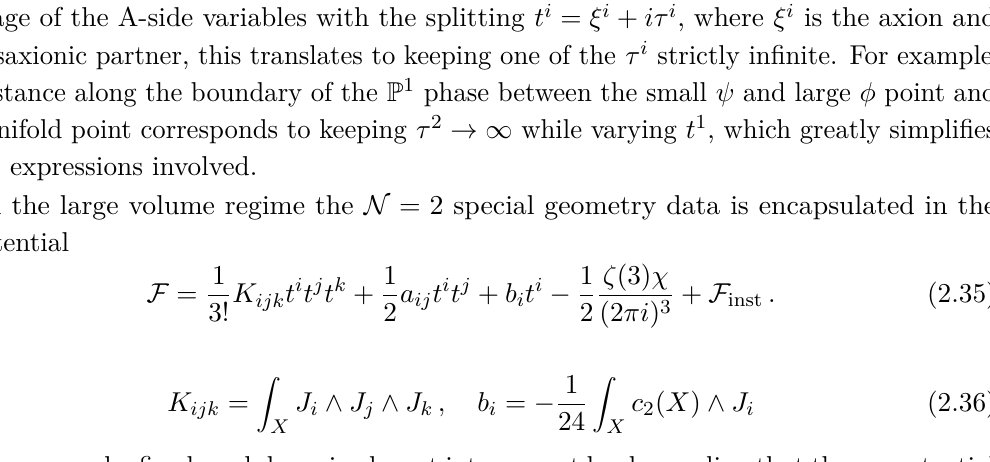
Figure 1 . Schematic plot of the (mirror) moduli space of P 4 shown distances are the ones computed in said paper. The moduli space of P 4 analogous